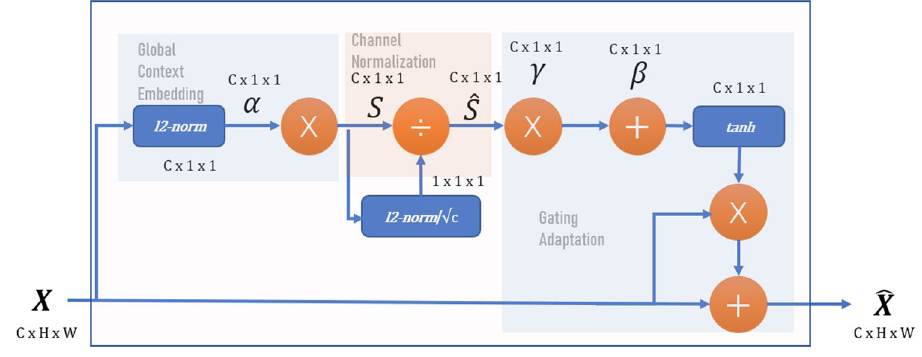
Fig. 2 The structure of Gated Channel Transformation